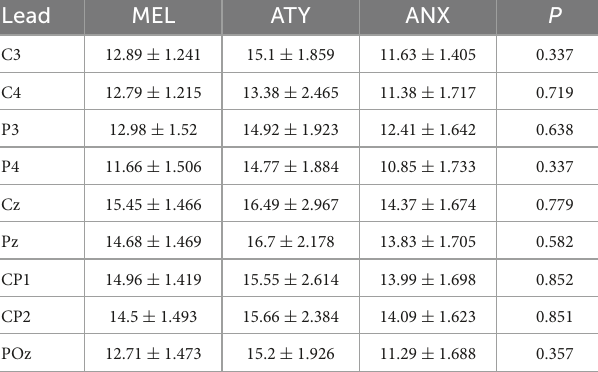
TABLE 6 Comparison of amplitude of baseline visual P300